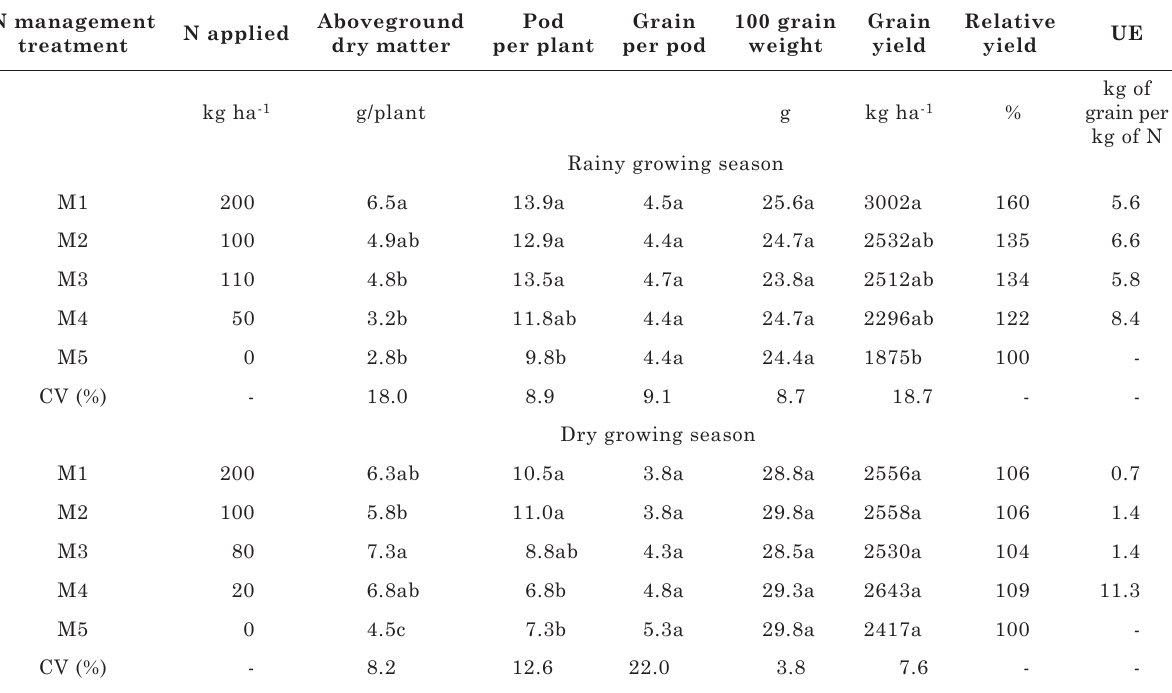
Table 1. quantity of N applied, aboveground dry matter, yield components, grain yield, relative yield, use efficiency of the N applied (ue) of common bean cv. Perola as affected by N applications in the rainy and dry growing